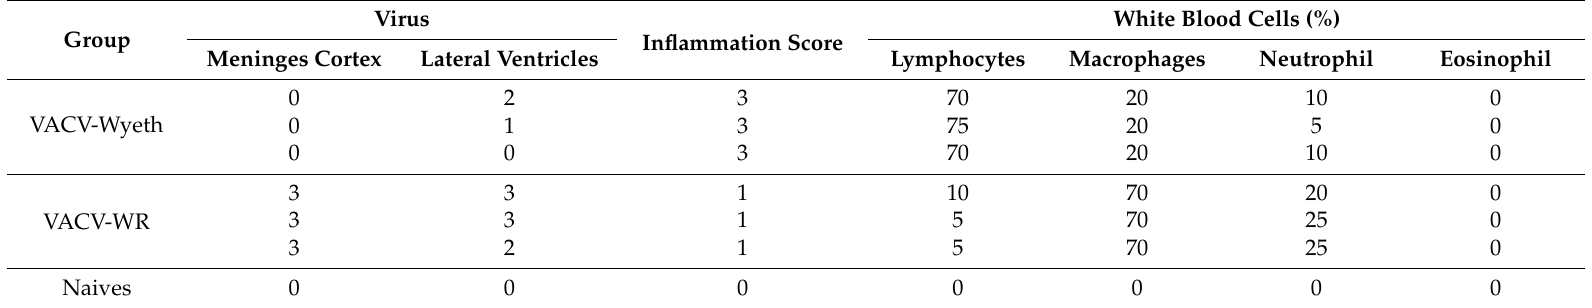
Table 1. Histology evaluation of viral presence and immune response at the symptomatic stage following infection. Virus Group Inflammation